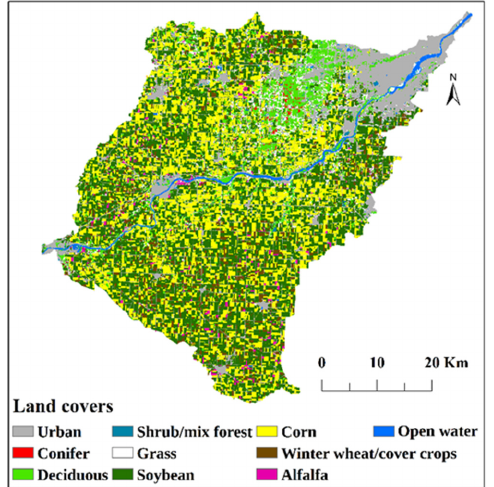
Figure 2. Reclassified USDA Land Use/Land Cover (LULC) image over the Lower Maumee River watershed in 2018 (Data source: [52]).